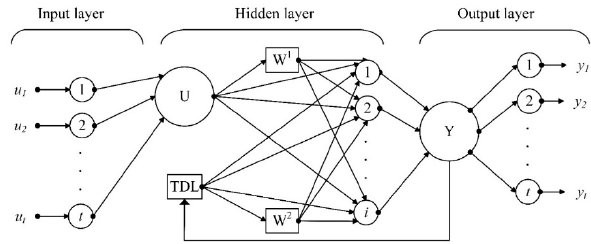
Figure 2. Architecture of a nonlinear auto-regressive neural network with exogenous input (NARXnn).